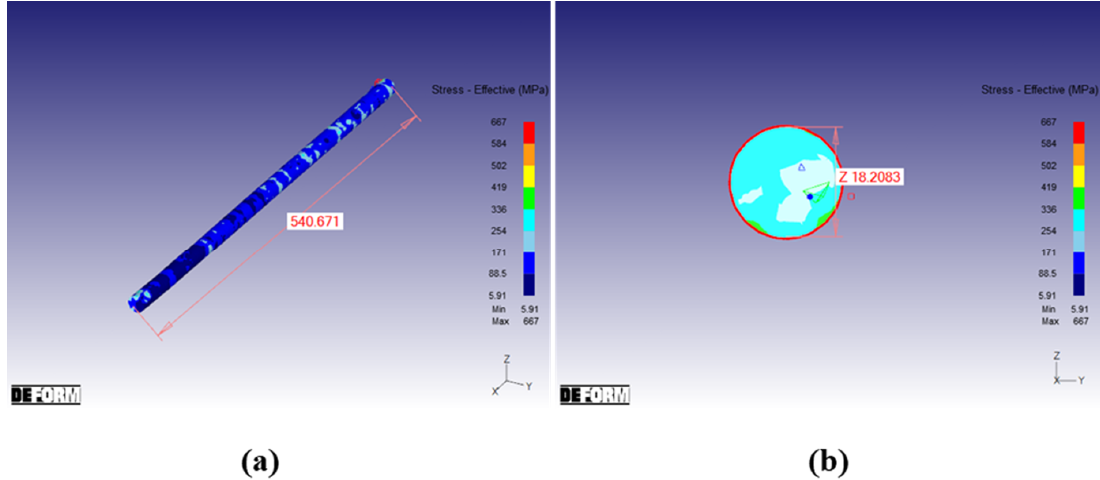
Figure 4. ( a ) The final length of the swaged rod, and ( b ) the stress distribution over a particular cross section.